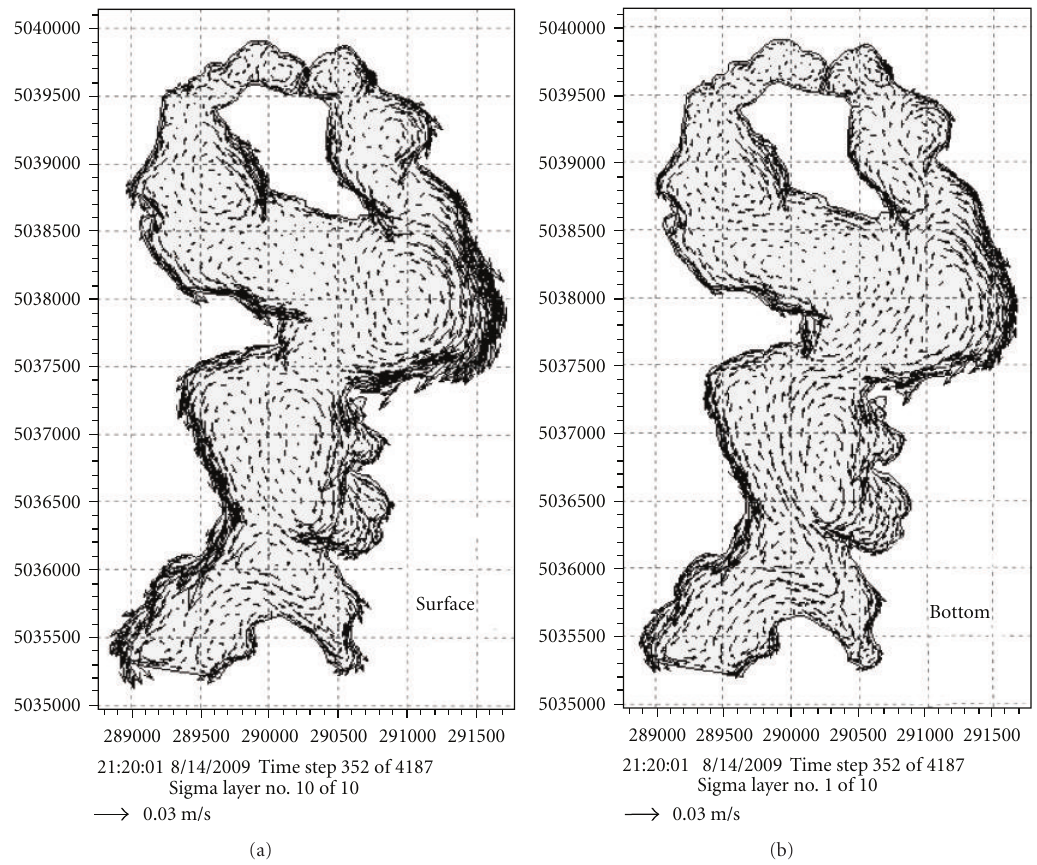
Figure 5: The simulated wind-induced general flow pattern in the surface and bottom